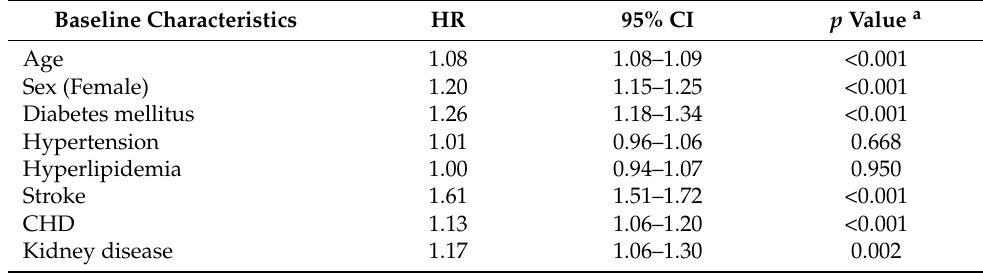
Table 3. Baseline characteristics predicted the risk of dementia for the whole